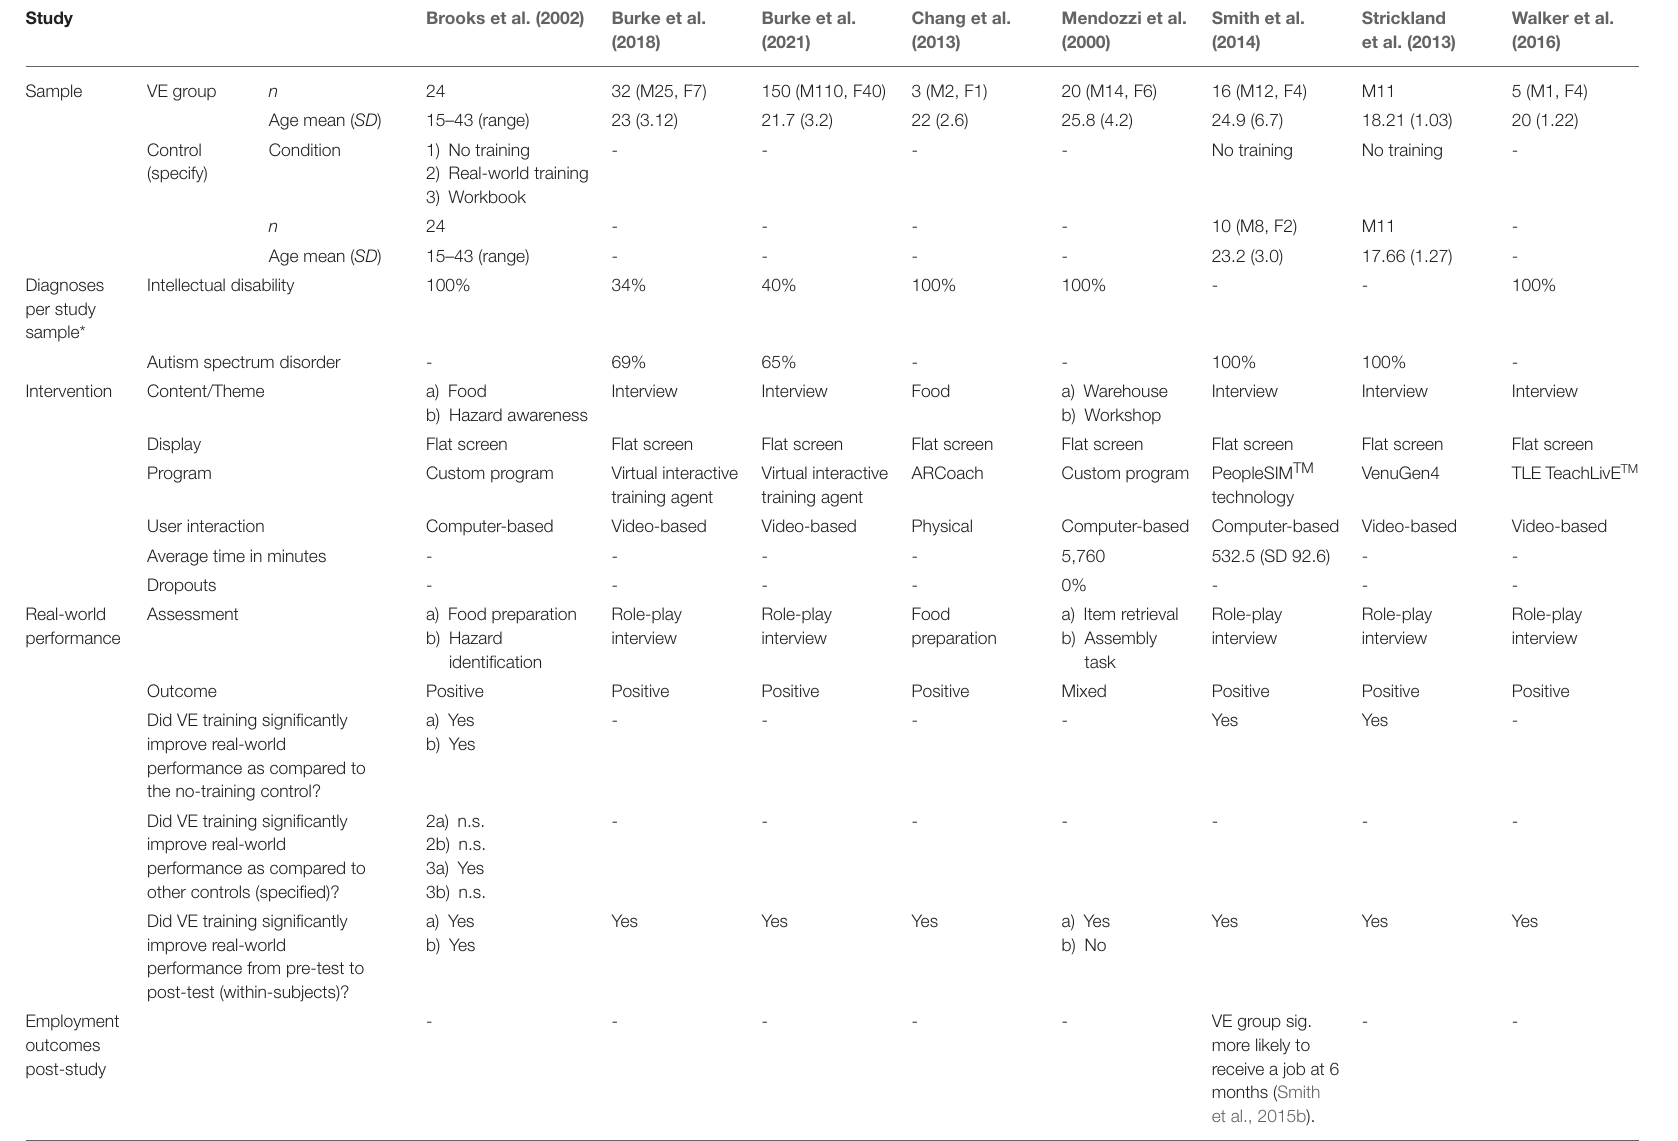
TABLE 1 | Summary of included